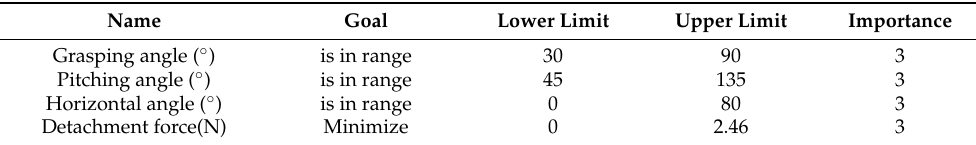
Table 5. Constraints of machine parameters and responses.